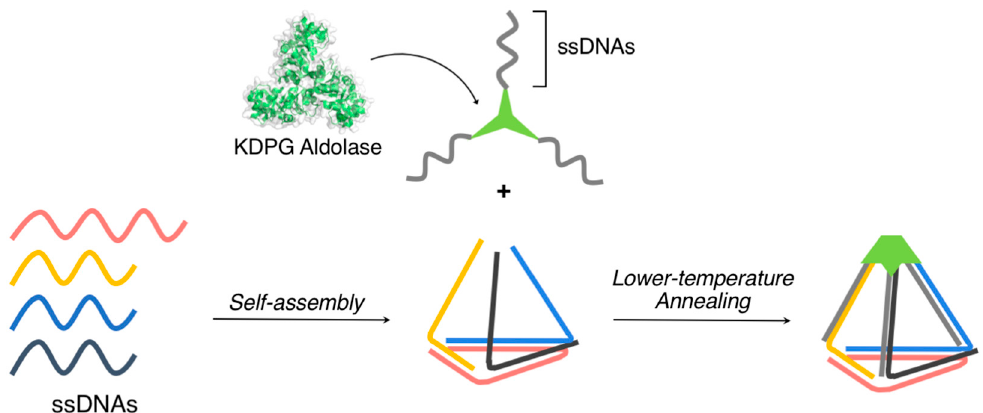
Figure 16. Three-dimensional cage-like supramolecular architecture obtained by the complexation of a homotrimeric protein containing three ssDNAs with a triangular DNA nanostructure bearing three complementary ssDNAs through DNA hybridization. Adapted from [118]. Copyright 2019 American Chemical Society.